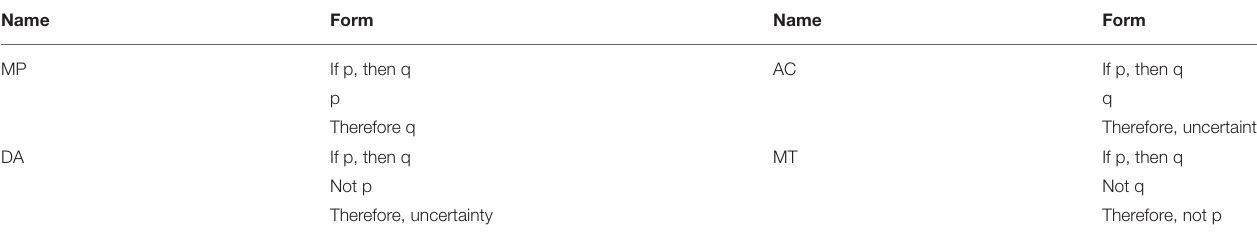
TABLE 1 | Four forms of conditional propositions